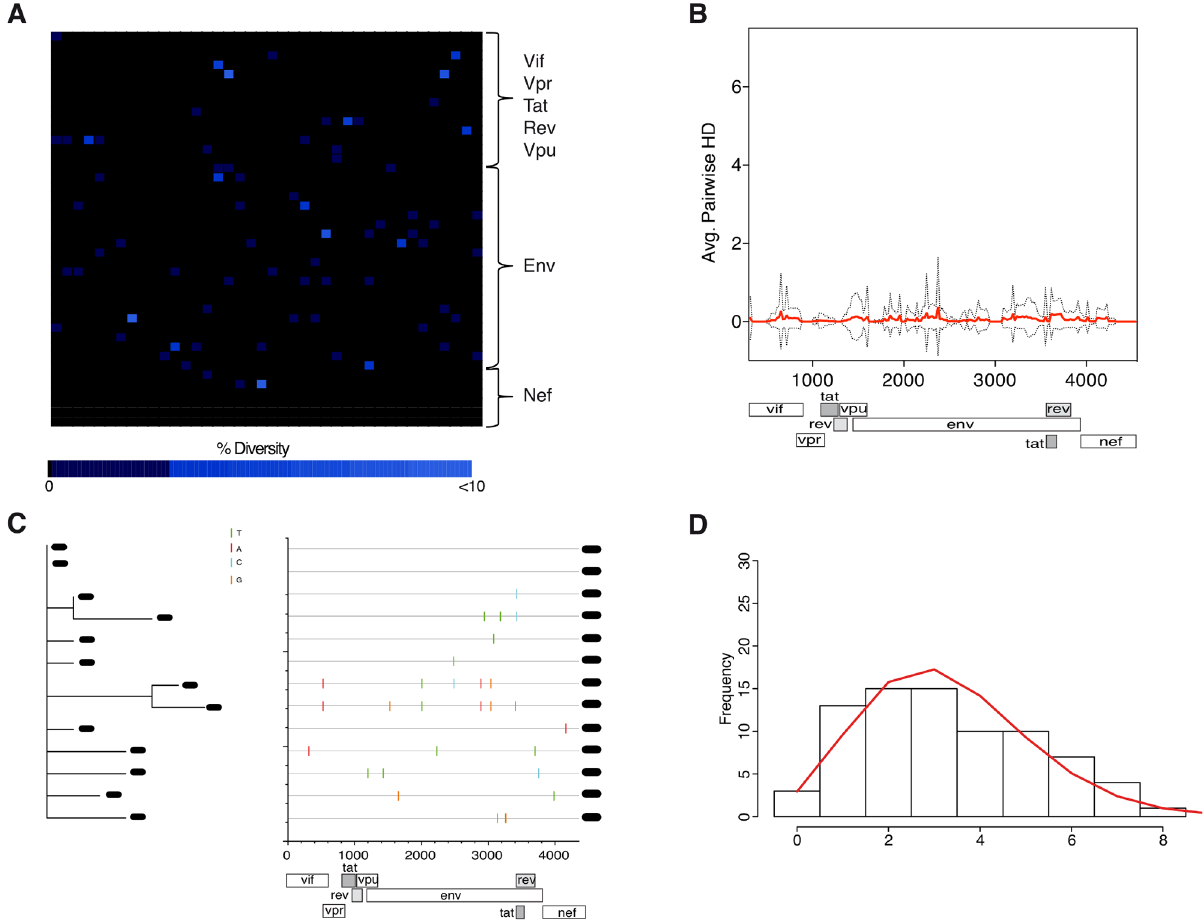
Fig 2. Subject 571373 exhibits low env diversity by both 454 and SGA/S reflective of a single founder virus. 454 and SGA/S analysis of 3 0 half sequences from subject 571373 (Fiebig stage II/III). (A) Heat map illustrating a small number of sites exhibiting low-level amino acid sequence diversity across the 3 0 half of the HIV-1 genome as detected by 454 deep sequencing. Plotted is the percentage of amino acid diversity at each position with the first amino acid of Vif located in the top left corner of the grid and last amino acid of Nef located in the bottom right corner. Completely conserved residues are black and low-level variant residues ( < 10%) are dark blue. (B) The average pairwise hamming distance calculated from 454 sequencing reads for the 3 0 half of the genome is plotted with the APHD of 0.063 (red line) and standard deviation (dotted black line) shown. The plot shows a relatively uniform population with random sites throughout the genome exhibiting low-level diversity. (C) SGA/Ss from subject 571373 covering the 3 0 half of the HIV-1 genome display limited structure on a neighbor-joining (NJ) phylogenetic tree (left) and few nucleotide changes from the intrasubject consensus. The highlighter plots (right) compare sequences for each subject ’ s sequence set to an intrasubject consensus (uppermost sequence) and illustrates the pattern of nucleotide base mutations within sequences using short color-coded bars. (D) Hamming distance analysis of SGA/Ss showing infection by a single virus with Hamming distance frequencies conforming precisely to model predictions of a single virus infection (red line). As further support for a single founder virus the estimated time to a single most recent common ancestor (MRCA) of 36 days (23 – 49 days) overlapped with the estimated clinical duration of infection based on Fiebig stages (18 – 37 days).